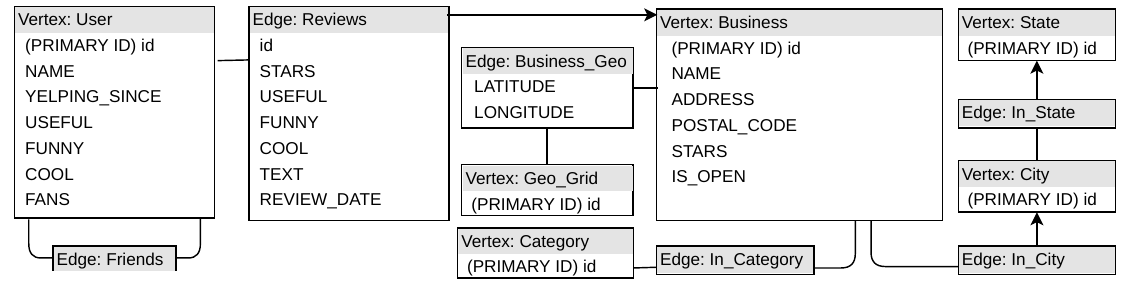
Figure A3. A UML diagram of the graph design of the Yelp dataset in TigerGraph.